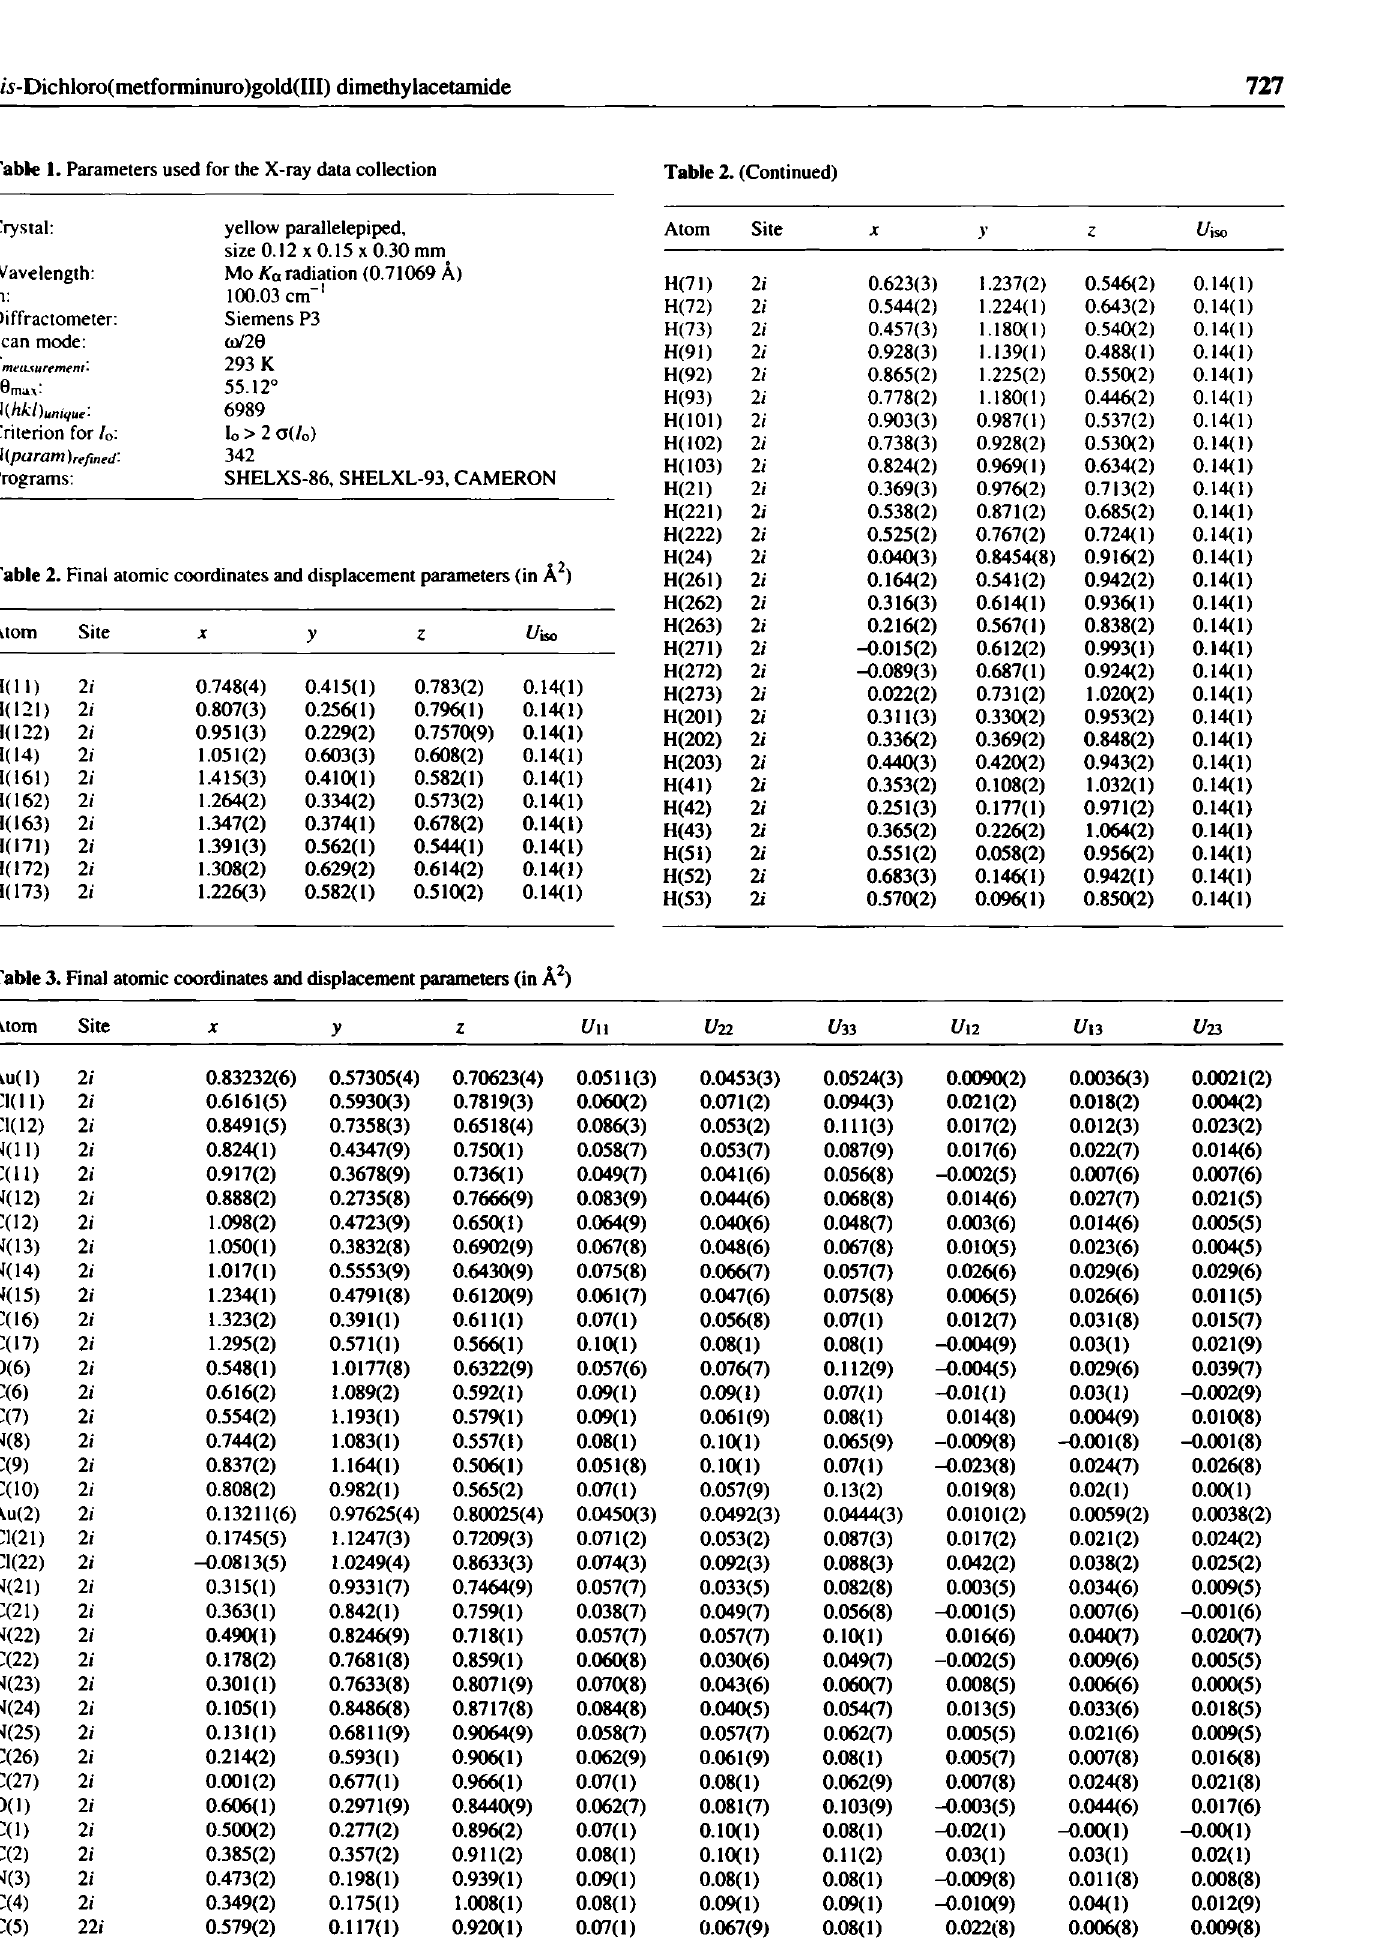
Table I. Parameters used for the X-ray data collection